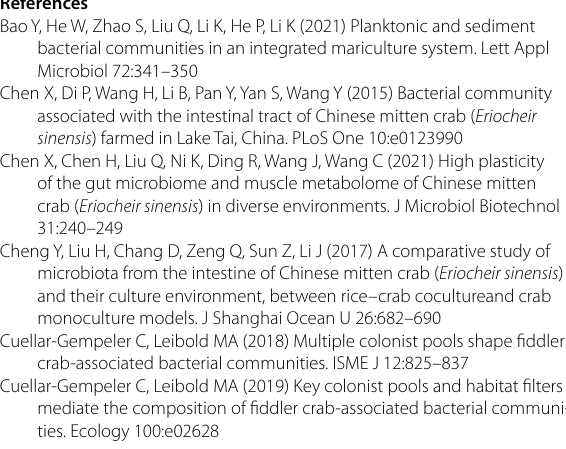
Additional file 8: Figure S3 . The community heatmap shows 50 domi- nant Firmicutes OTUs and their relative abundances. The most dominant